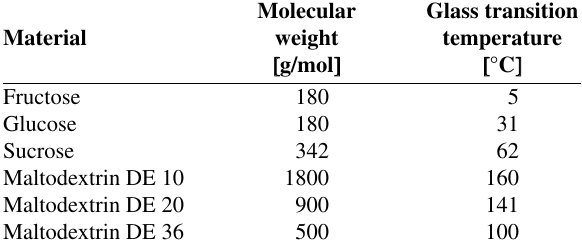
Table 1. – Glass transition temperature of different carbohydra- tes Molecular Glass